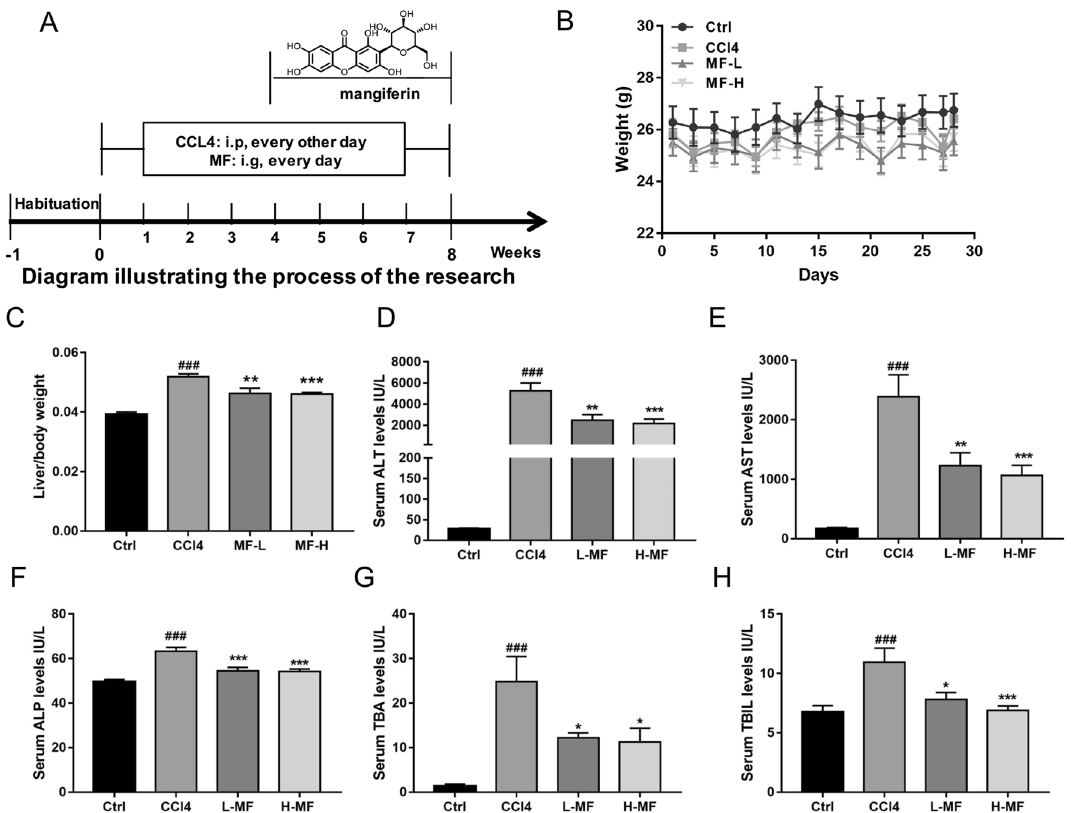
Figure 1. Mangiferin relieves liver injury induced by CCl4. ( A ) The diagram of treatment of mouse model. ( B ) Body weight. ( C ) The liver/body weight. ( D ) Serum ALT level. ( E ) Serum AST level. ( F ) Serum ALP level. ( G ) Serum TBA level. ( H ) Serum TBIL level. The mice were injected intraperitoneally 10% CCl4 (CCl4 was dissolved in olive oil) at dose of 2 mg/kg of body weight for 8 weeks, the control group mice were injected with an equal amount of olive oil. The mangiferin treatment group were injected intraperitoneally 10% CCl4 and orally administrated mangiferin at the dose of 50 mg/kg and 100 mg/kg (0.1 ml/10 g of body weight). Date are presented as means ± S.E.M. (n = 8). ### p < 0.001, compared with control group; * p < 0.05, ** p < 0.01 and *** p < 0.001, compared with CCl4 group. Ctrl, control group; CCl4, carbon tetrachloride treated group; L-MF, low dose of mangiferin (50 mg/kg); H-MF, high dose of mangiferin (100